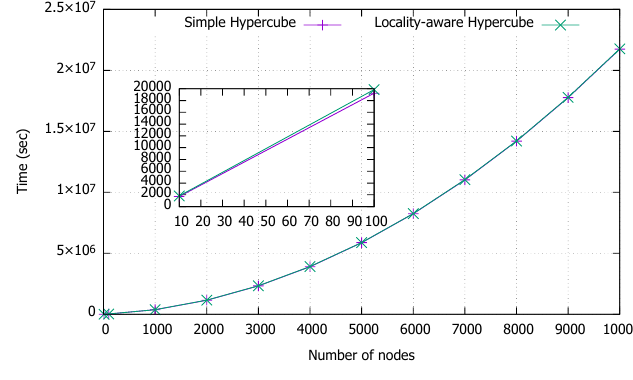
Figure 5. A comparison between the control traffic of simple Hypercube and locality-aware Hypercube.